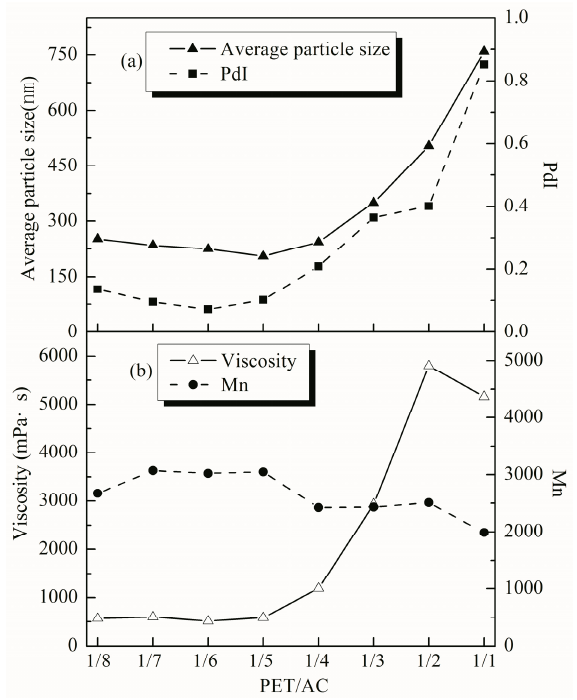
Figure 2. E ff ect of the PET / AC ratio on the properties of the emulsion. ( a ) Average particle size and PdI; ( b ) viscosity and M n . Conditions: The amount of HEMA was 30% of total weight of the PET and acrylate monomers, the ratio of AA / MAA / BA / St was 1.2 / 2.6 / 10.9 / 24.5 in this series reaction.